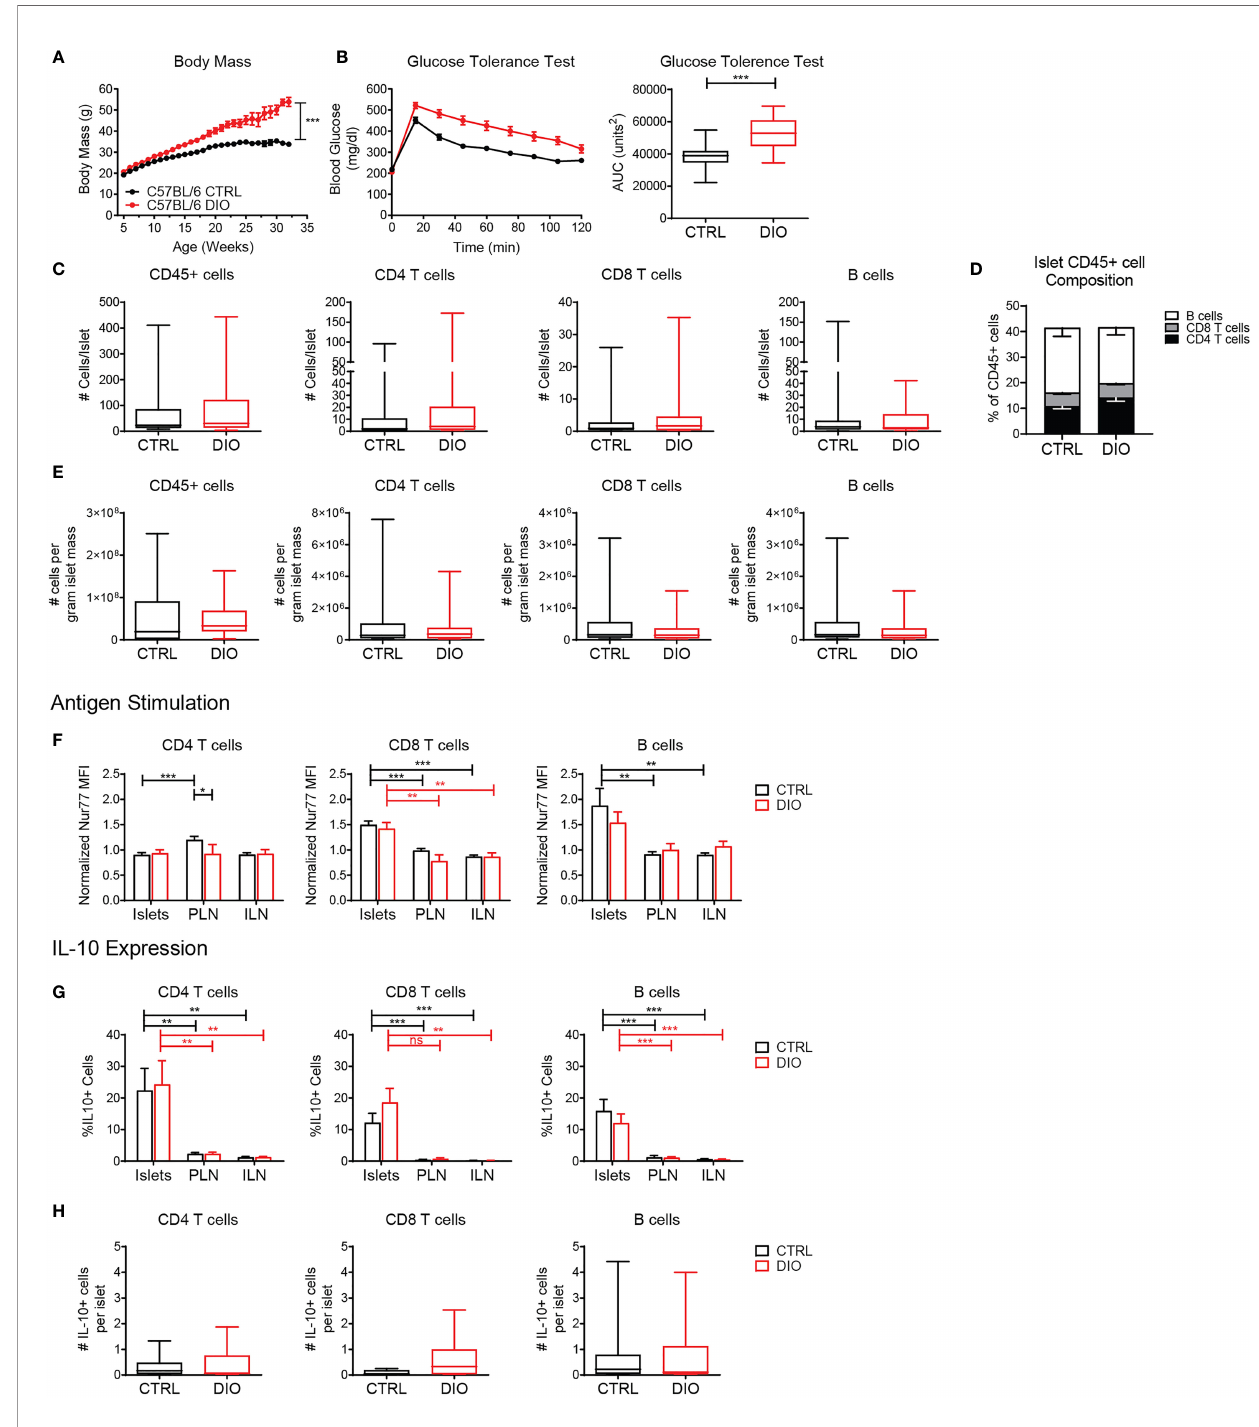
FIGURE 8 | Islet T cells and B cells maintain a regulatory phenotype under metabolic stress in the diet-induced obesity model. Mice were maintained on a high fat diet (DIO) or control diet (CTRL). (A) Body weight. (B) Glucose tolerance test. Blood glucose levels and area under the curve (AUC) following glucose challenge. (C) Number of cells per islet in CTRL and DIO mice. (D) Percent of CD4 T cells, CD8 T cells and B cells of the islet CD45+ population. (E) Estimated number of cells per gram of islet tissue, based on 0.035mg islet weight per gram of mouse body weight. (F) Normalized Nur77-GFP reporter expression in CTRL and DIO B6.Nur77- GFP mice. (G, H) IL-10-GFP reporter expression in CTRL and DIO B6.TIGER mice. (A – E) n=32 control mice, 42 DIO mice from 12 independent experiments. (F) n=19 control mice, 8 DIO mice from 6 independent experiments. (G, H) n=10 control mice, 10 DIO mice from 3 independent experiments. (A – H) Statistics: *p < 0.05, **p < 0.01, ***p < 0.001, ns, not signi fi cant. Error bars: SEM. (B, C) Two-tailed student ’ s t test. (A, F – H) Two-way ANOVA with Bonferroni post-test. (C, D) Mann Whitney two tailed